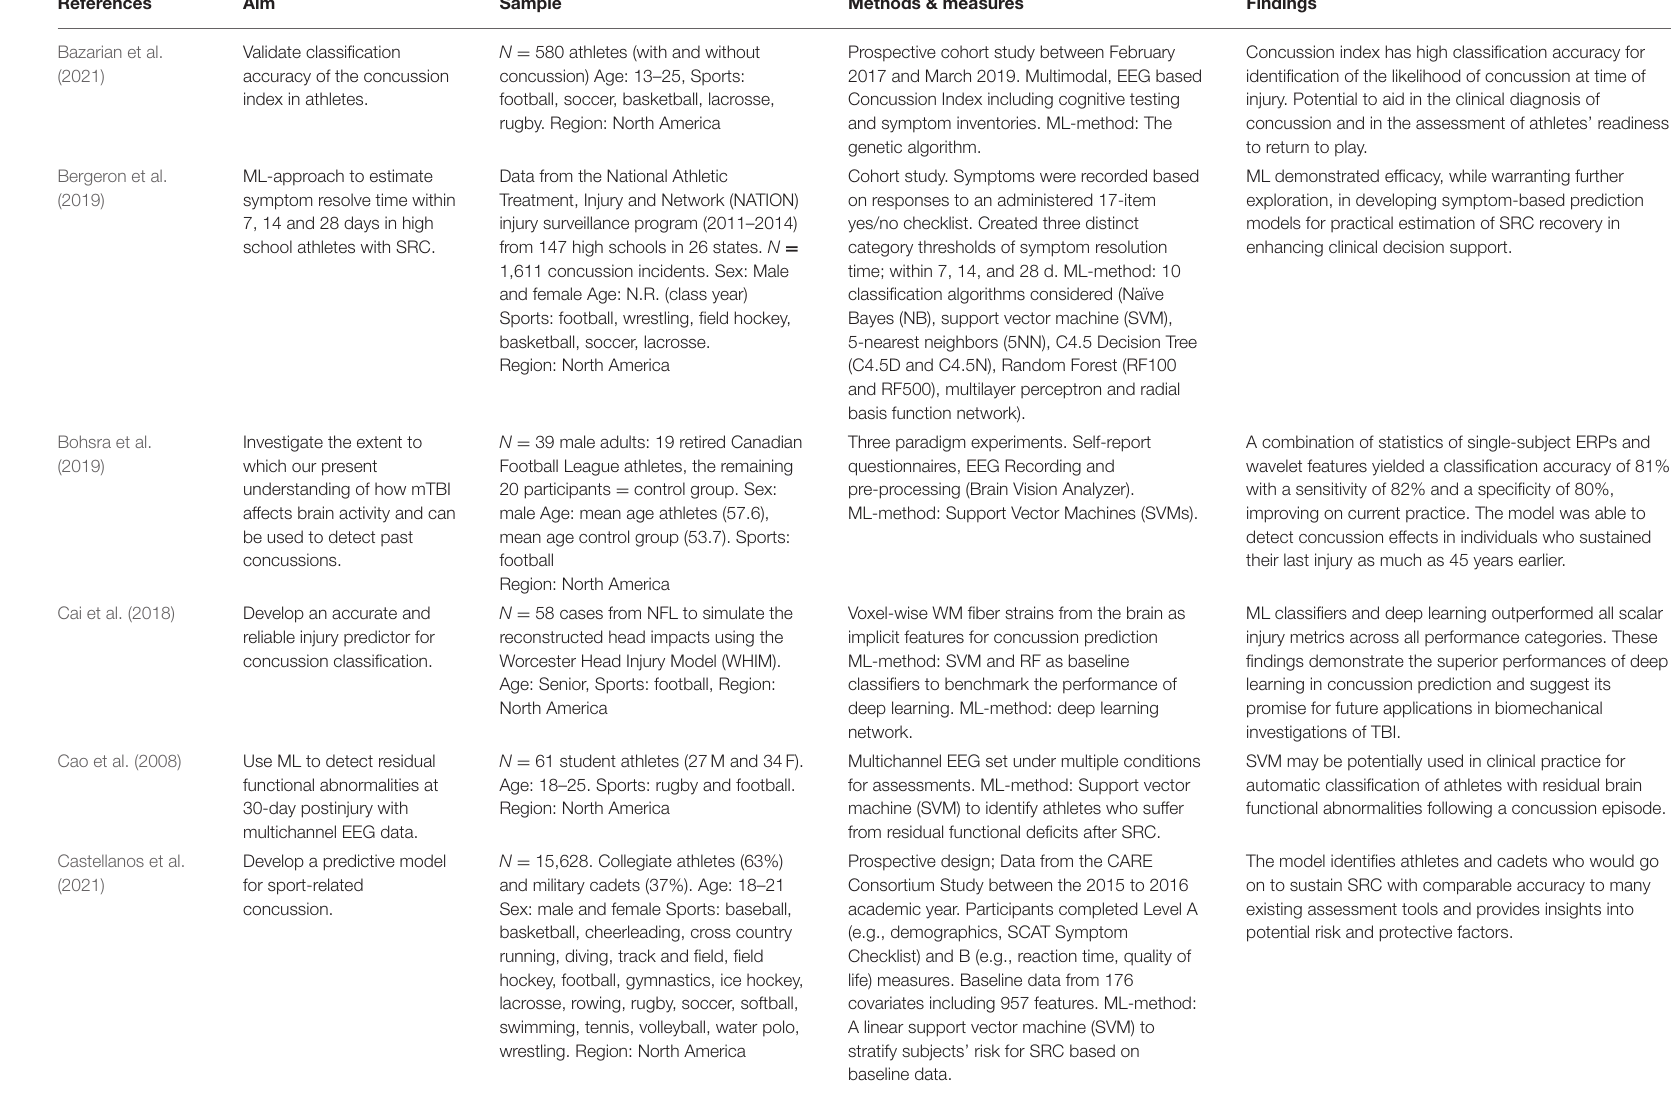
TABLE 1 | Results of the scoping